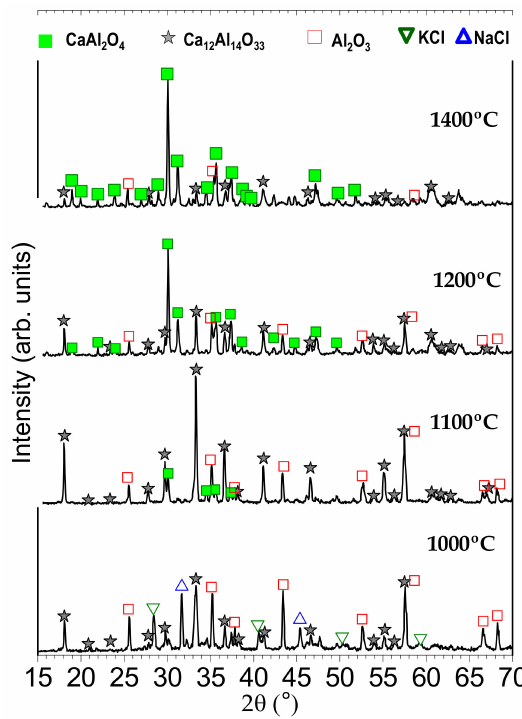
Figure 1. X-ray di ff ractograms (XRD) of synthesized calcium oxide (CaO): Eu, Nd phosphor heated at 1000, 1100, 1200 and 1400 ◦ C for 2 h in air atmosphere, employing a salt / CAO molar ratio of 3:1. The symbols highlight aluminum oxide (Al 2 O 3 ) (red-open squares), sodium chloride (NaCl) (blue-open triangles), potassium chloride (KCl) (green-open triangles), monocalcium aluminate (CaAl 2 O 4 ) (green squares) and dodecacalcium hepta-aluminate (Ca 12 Al 14 O 33 ) (gray